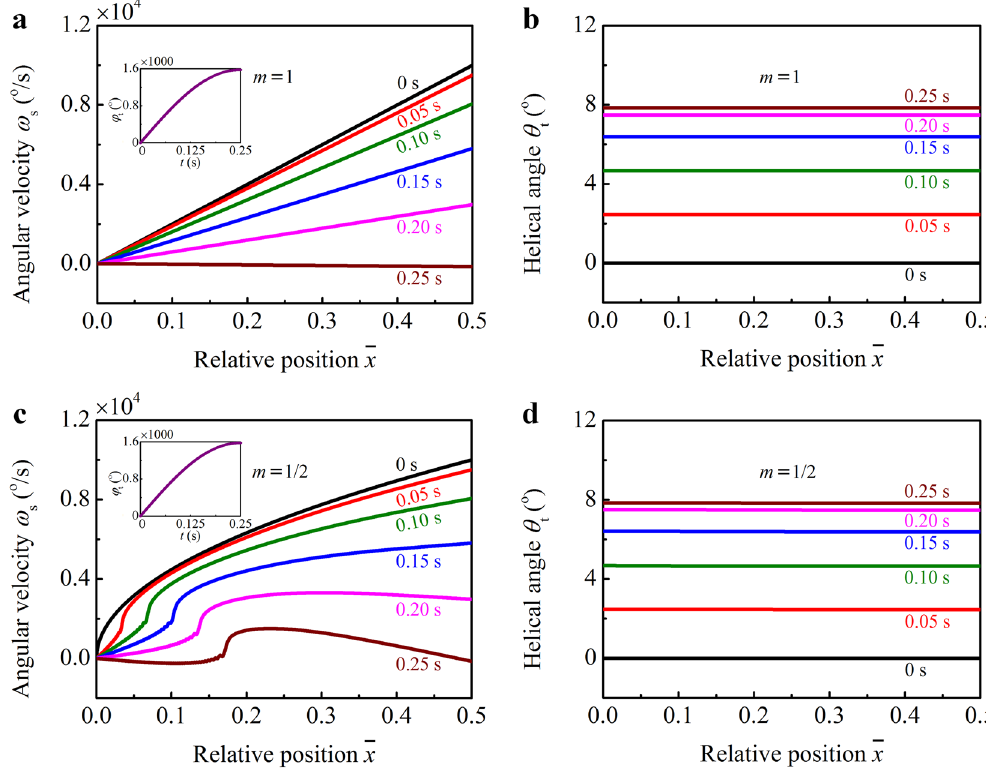
Figure 4. Parametric study of the winding dynamics. Angular velocity ω s of the string and helical angle θ t of the threads are plotted with x for different initial conditions ω ω = x x l ( , 0) / m m , where m = 1 in ( a ) and ( b ), and s dm s m = 1/2 in ( c ) and ( d ). Temporal evolution of the winding angle ϕ t of the threads is shown in the inserts of ( a ) and ( c